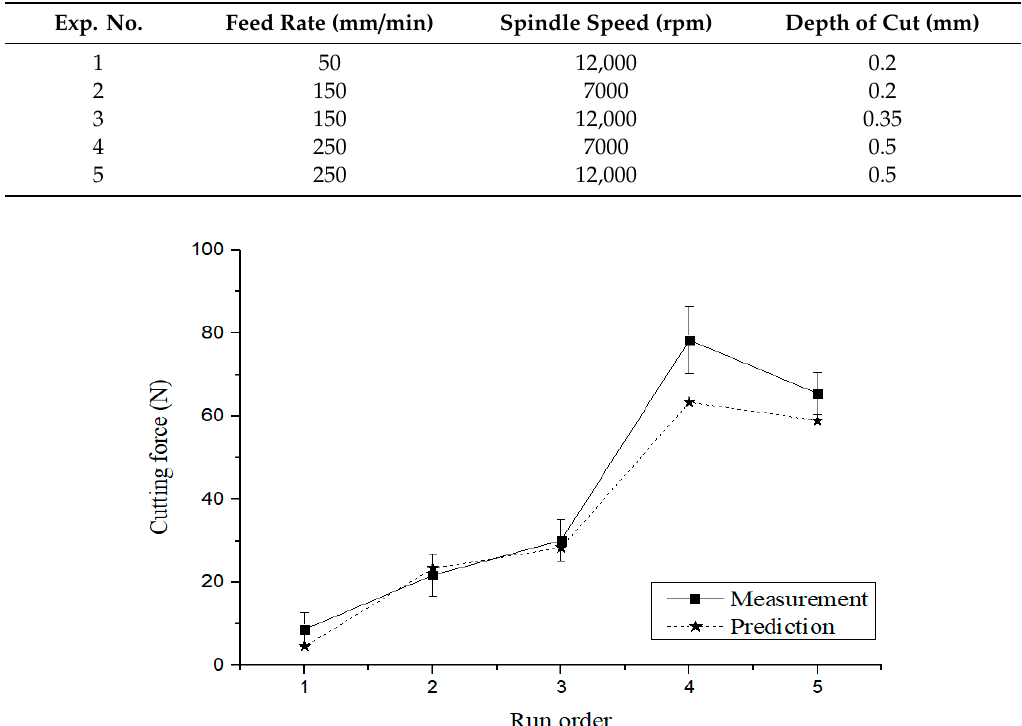
Table 11. Machining conditions of the verification experiments.